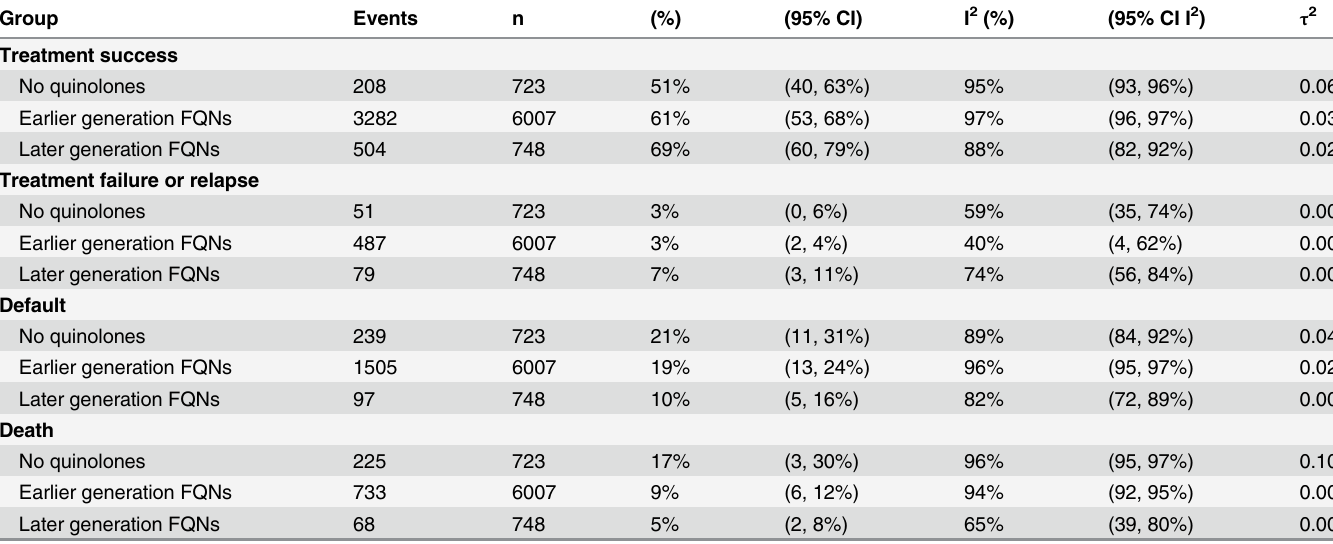
Table 2. Pooled treatment outcomes by fluoroquinolone use, with pooled Der Simonian and Laird random effects estimates. Group Events